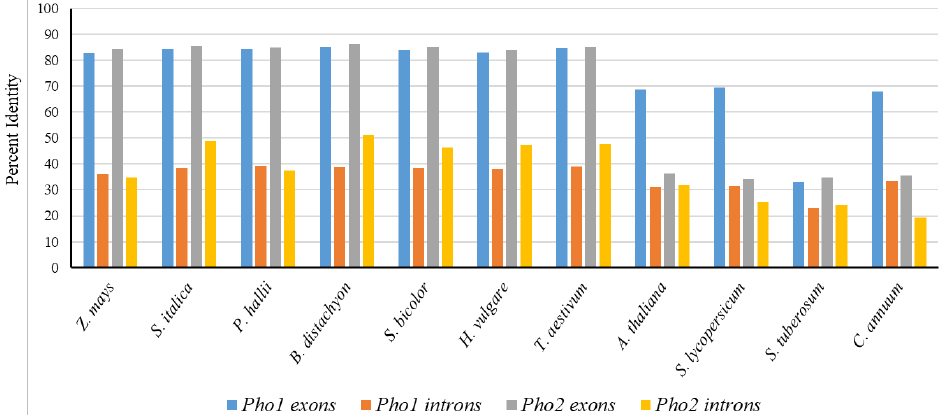
Figure 2. Percent identity of exons and introns in PHO1 and PHO2 of monocots and dicots with respect to exons and introns of O. sativa .